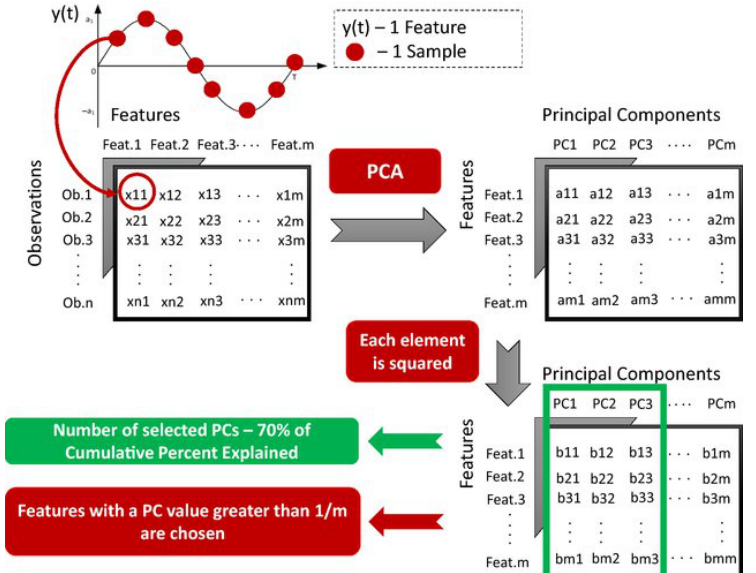
Figure 5. PCA-based procedure to rank and obtain the most crucial features and to limit the compu- tational cost of comparative